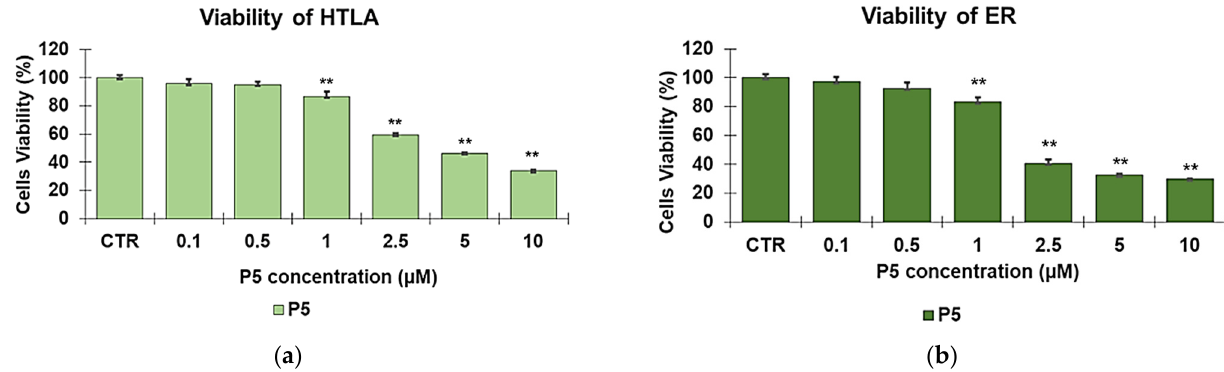
Figure 5. Cell viability was evaluated by CellTiter 96 ® AQueous One Solution Cell Proliferation Assay in HTLA-230 (HTLA, a ) and HTLA-ER (ER, b ) cells exposed to increasing concentrations of P5 (0 – 10 µM) for 24 h. Bar graphs summarize quantitative data of the means ± SEM of three independent experiments. ** p < 0.01 vs. Ctr cells.